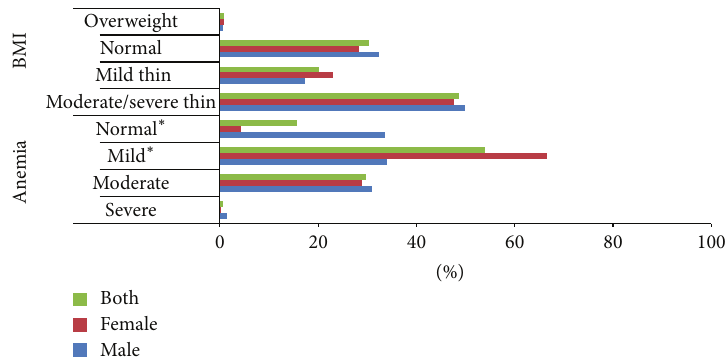
Figure 1: Prevalence of anemia and low BMI among studied adolescent males and females in Himalayan state of north India, 2010.